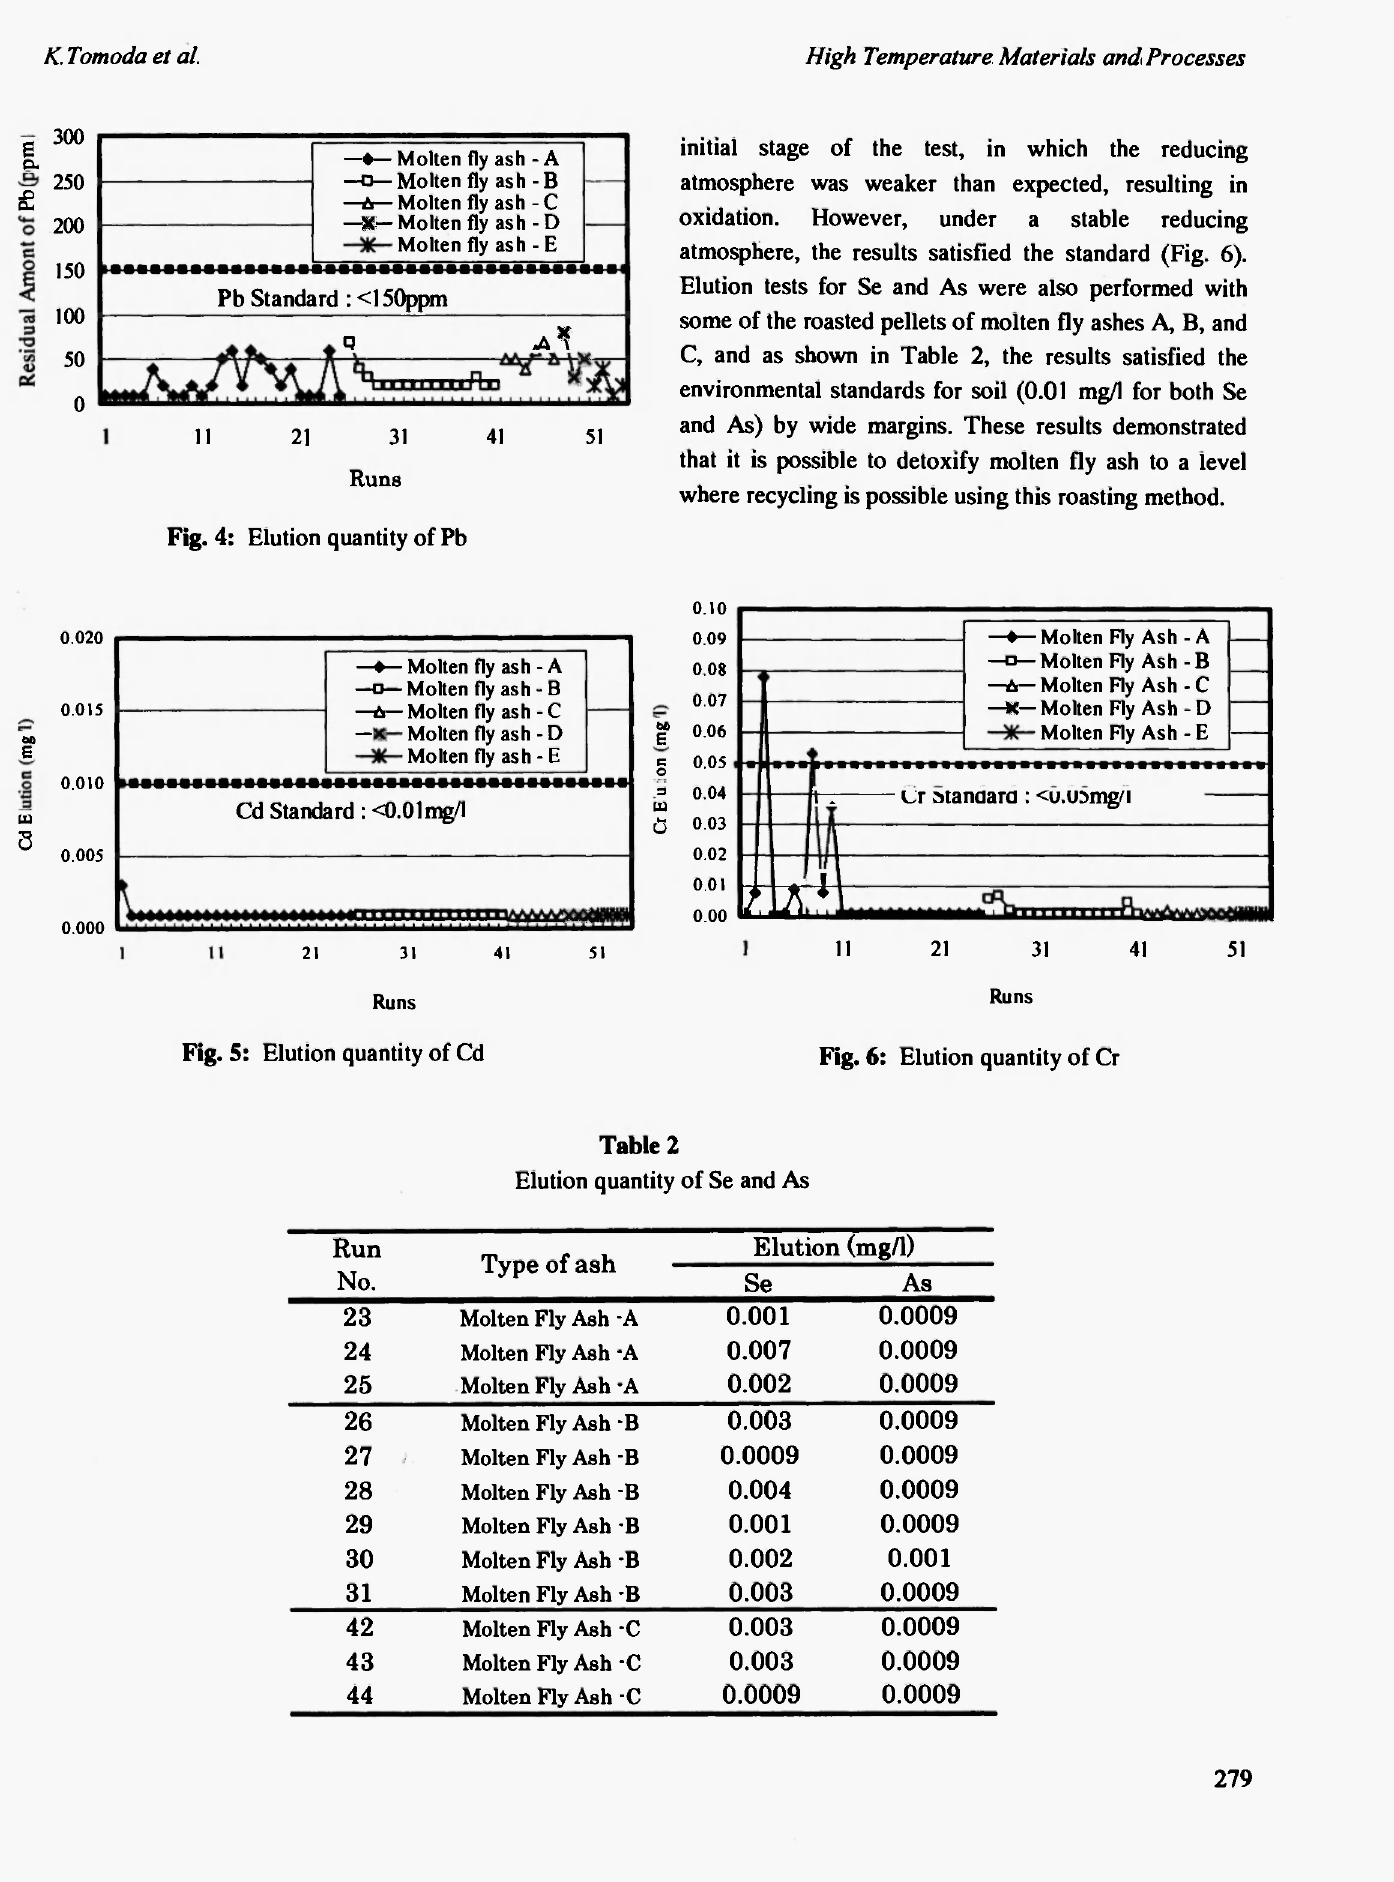
Elution quantity of Se and